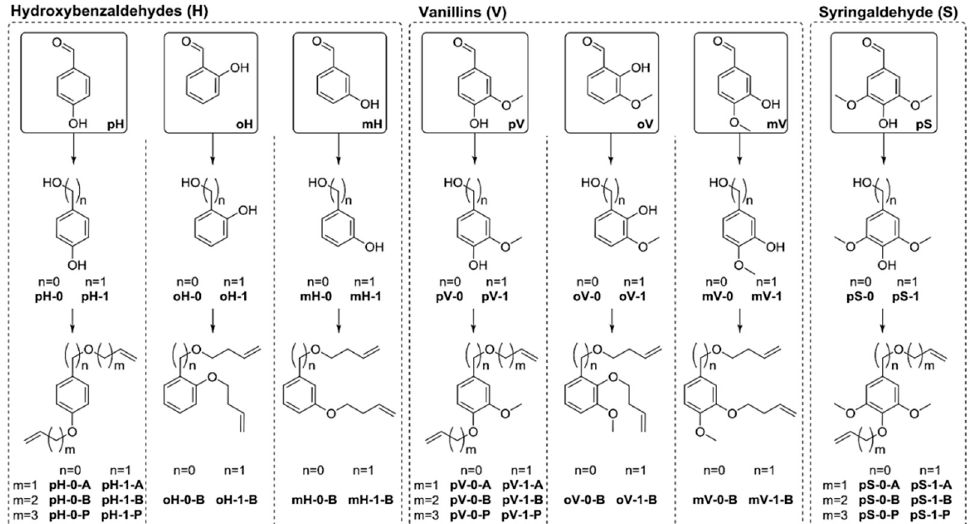
Figure 16. A library of 26 α , ω -dienes with lignin-inspired structural motifs and their ADMET polymerization. Reproduced with permission [55].